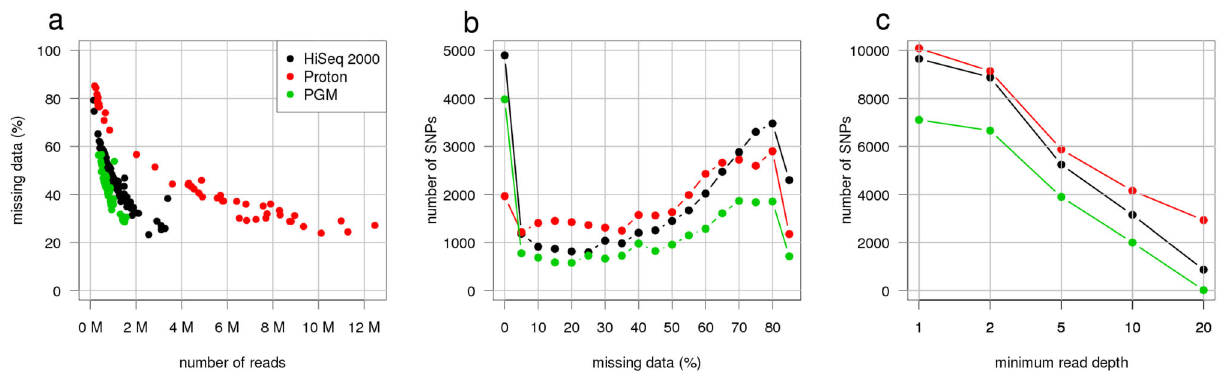
Figure 2. Relationship between number of sequence reads, missing data, sequencing depth and the number of SNP calls. ( a ) The average percentage of missing data per SNP in each sequenced sample is plotted as function of the number of sequence reads in that sample. ( b ) Histogram of missing data per SNP. ( c ) The number of SNP calls plotted against the minimum depth at a variant position in a given sample to make a successful genotype call. All SNP calls were made with the SAMtools pipeline. The minor allele frequency was set to 30% and the maximum rate of missing data was set to 50%. The sequencing platforms used for this study include Illumina HiSeq2000 (black), Ion Torrent PGM (green) and Ion Torrent Proton (red). The color code for all panels is given in the legend to ( a